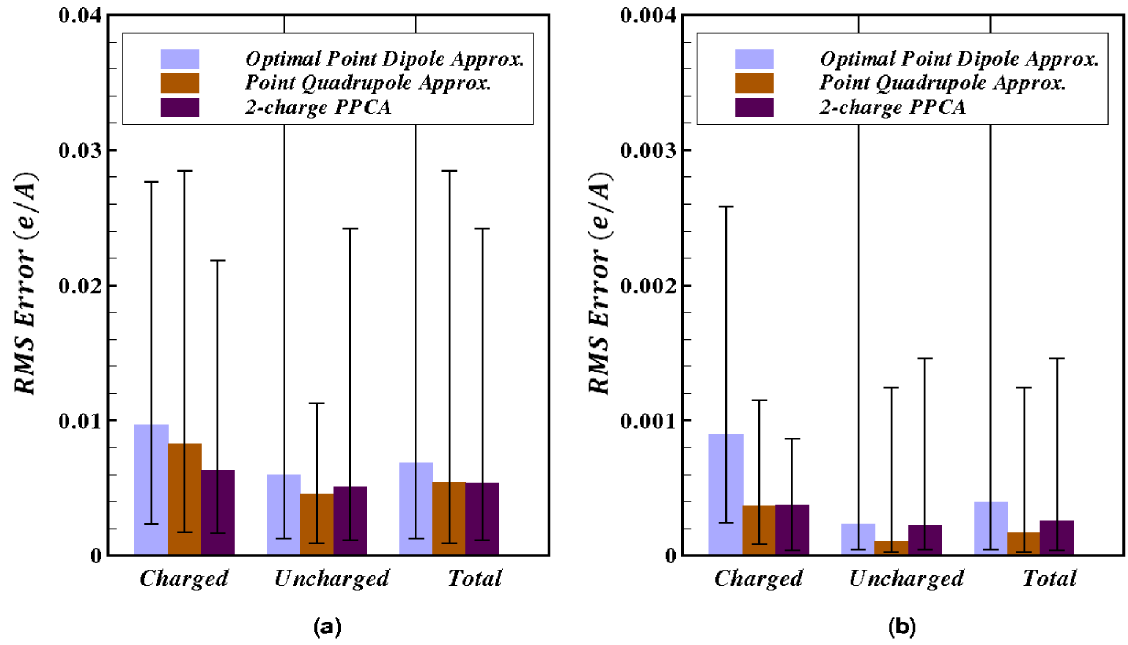
Figure 5. Accuracy of the 2-charge practical point charge approximation (PPCA). For a sample set of charge distributions relevant to biomolecular modeling. Accuracy of the point dipole and point quadrupole approximations are shown for comparison. Accuracy is calculated as the RMS error relative to the exact computation. ( a ) Error calculated at a distance of 10 A˚ & 2 R 0 where R 0 is the maximum extent of the charge distribution from the center of geometry. ( b ) Error calculated at a distance of 15 A˚ & 3 R 0 from the center of geometry. Error bars show the maximum and minimum absolute error. The upper values for the error bars that are cut off at the top are 0.14 and 0.006 in the left and right panels,